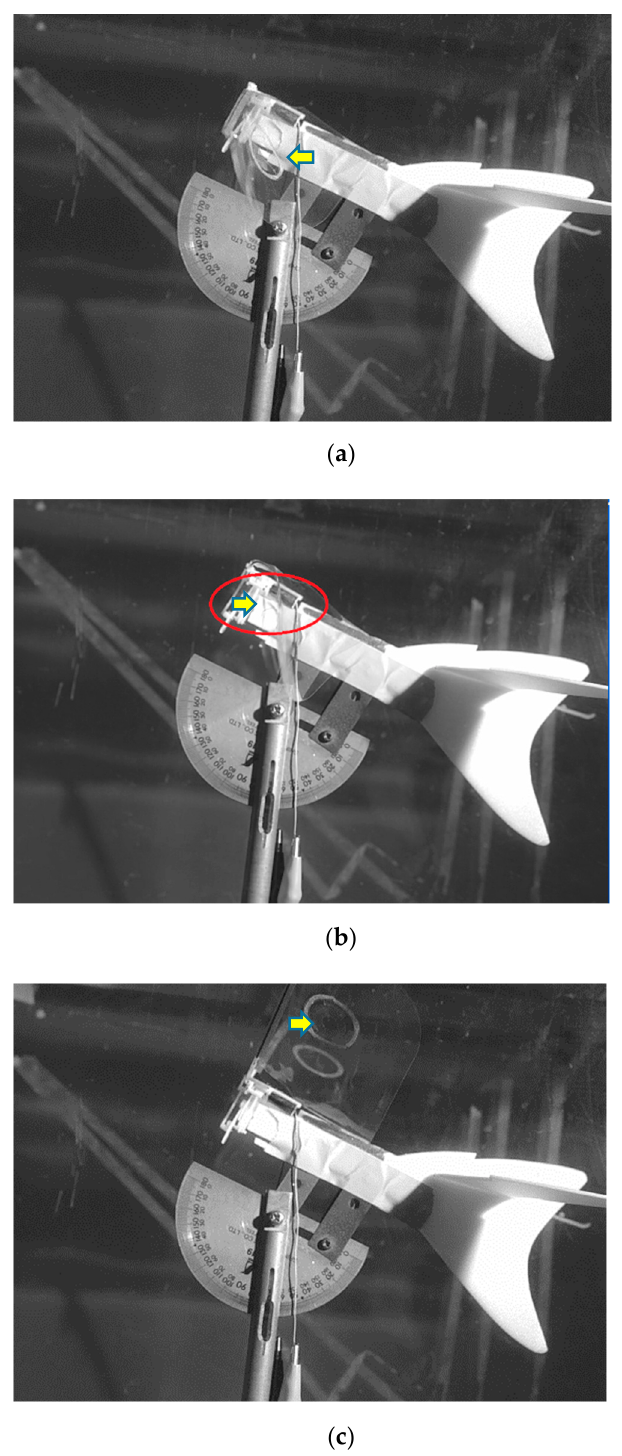
Figure 5. High speed photos of upstroke flapping: ( a ) Hole opening at the beginning of the up- stroke; ( b ) central disc-cap deforms 7.39 mm far away from the hole during the upstroke; ( c ) check-valve closed at the end of the upstroke.